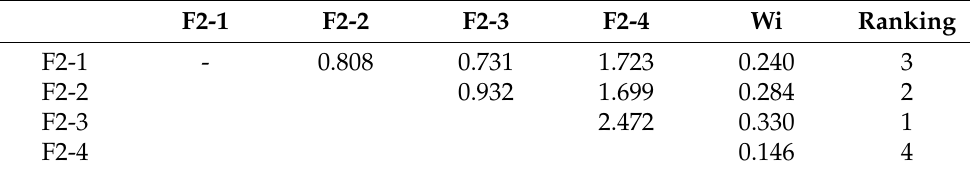
Table 9. Ranking of secondary factors in “green product manufacturing”.